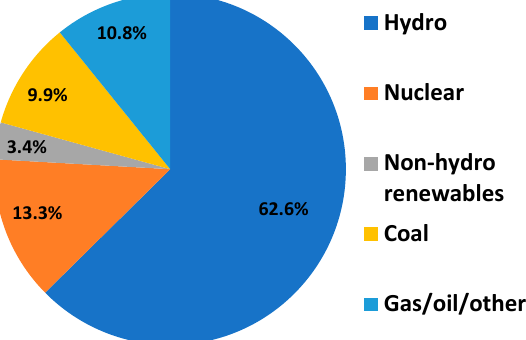
Figure 2. Canada’s energy mix for electricity generation 2014 [18].